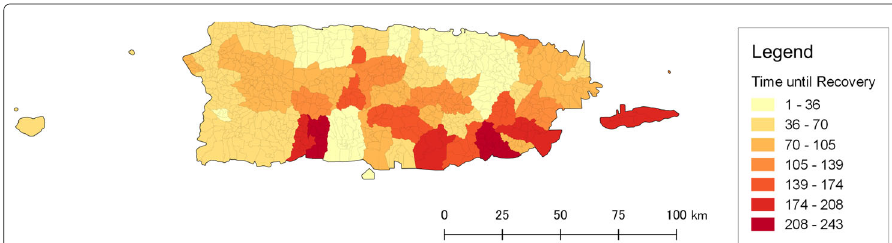
Fig. 4 Estimated recovery time T i of each community after Hurricane Maria